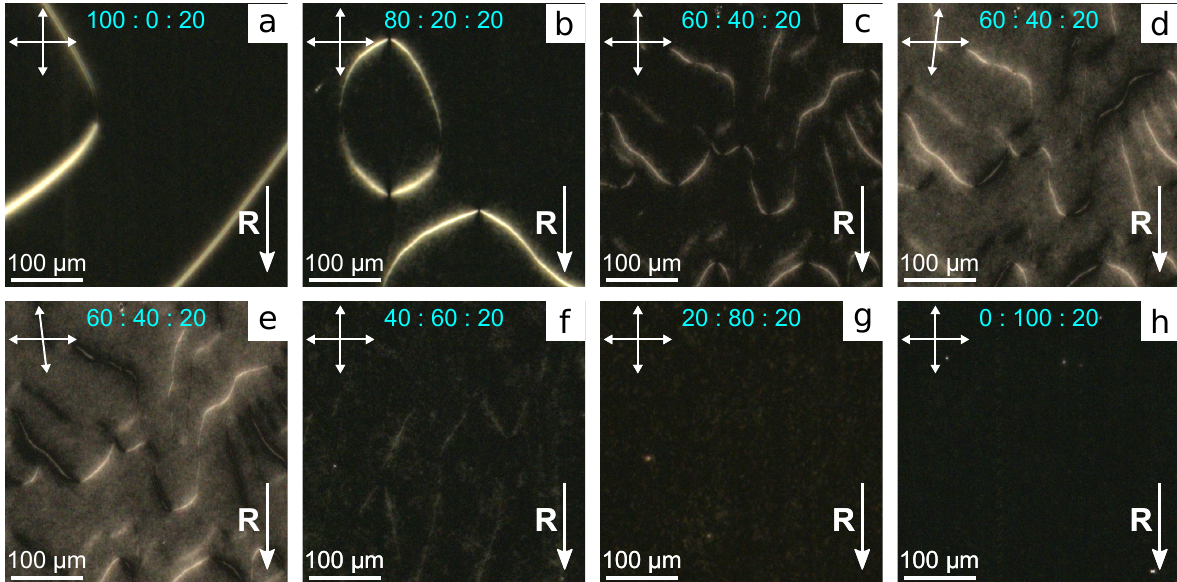
Figure 4. POM photos of LC cells with the bottom substrate covered with the rubbed PVA film and the top substrate covered with the film of polymer and LC mixture with the weight ratio PiBMA:PMMA:LN-396 equal to: ( a ) 100:0:20, ( b ) 80:20:20, ( c – e ) 60:40:20, ( f ) 40:60:20, ( g ) 20:80:20, and ( h ) 0:100:20. Photos are taken ( a – c , f – h ) in crossed polarizers, and at the angle between analyzer and polarizer ( d ) 83 ◦ and ( e ) − 83 ◦